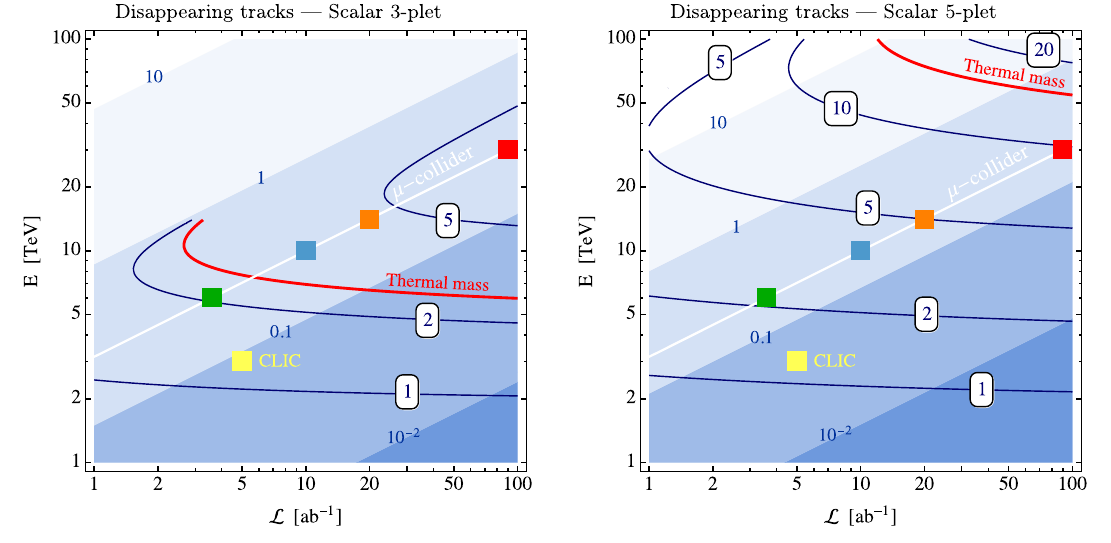
Fig. 15 Drell–Yan and W -fusion χχ production as a function of M χ . Left: scalar 3-plet cross-section for √ s = 30TeV cross-section for